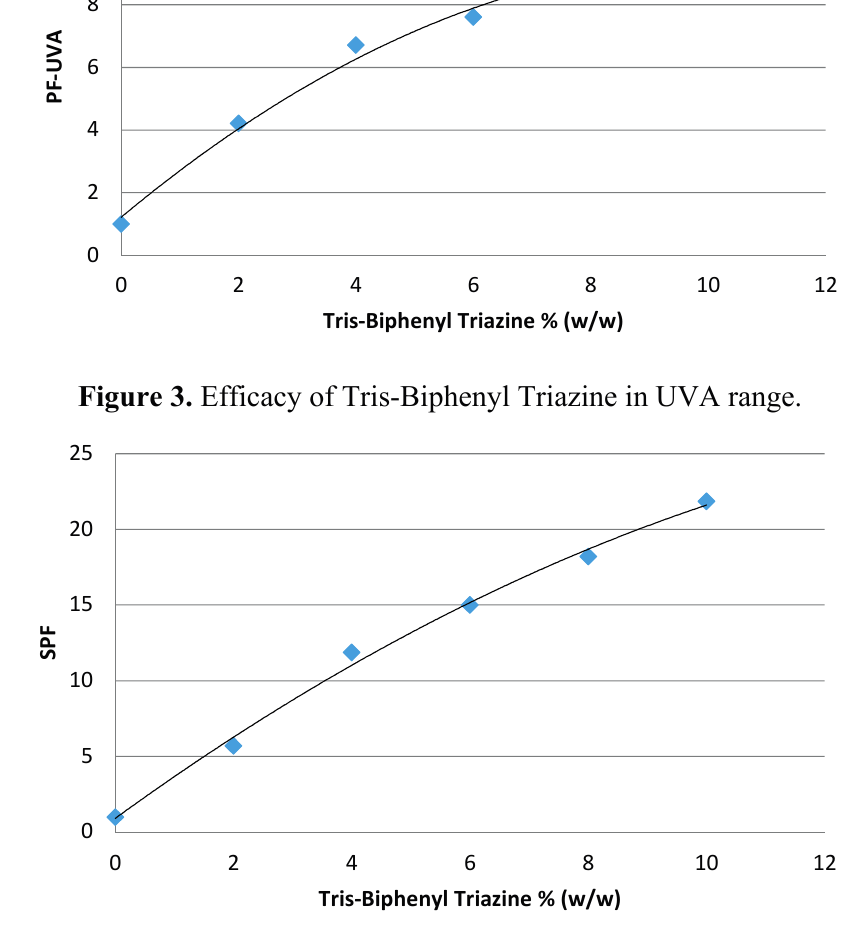
Figure 4. Efficacy of Tris-Biphenyl Triazine in UVB